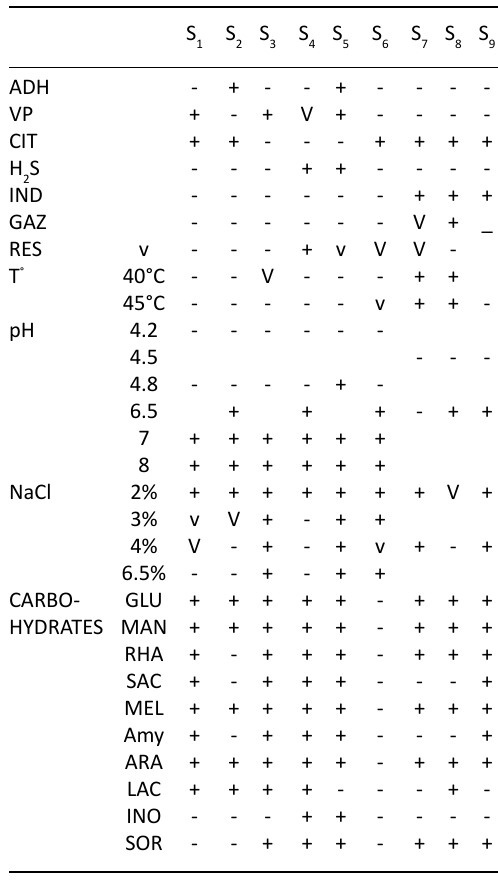
Table 3. Biochemical and physiological criteria of lactic acid bacteria isolated from camel